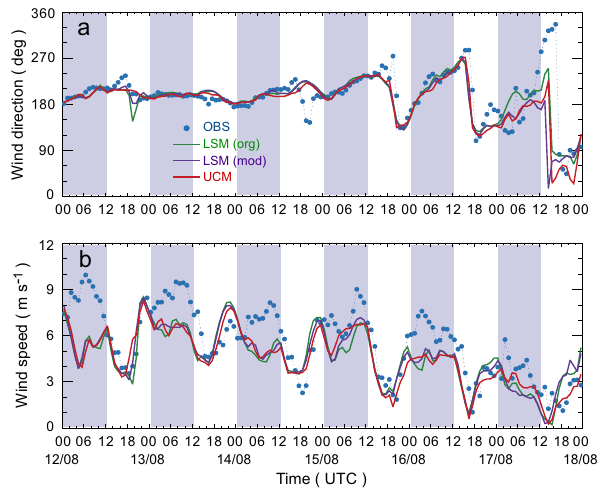
Fig. 11. Diurnal variations of the observed and simulated (a) wind direction and (b) wind speed at about 300m height a.g.l. at the La